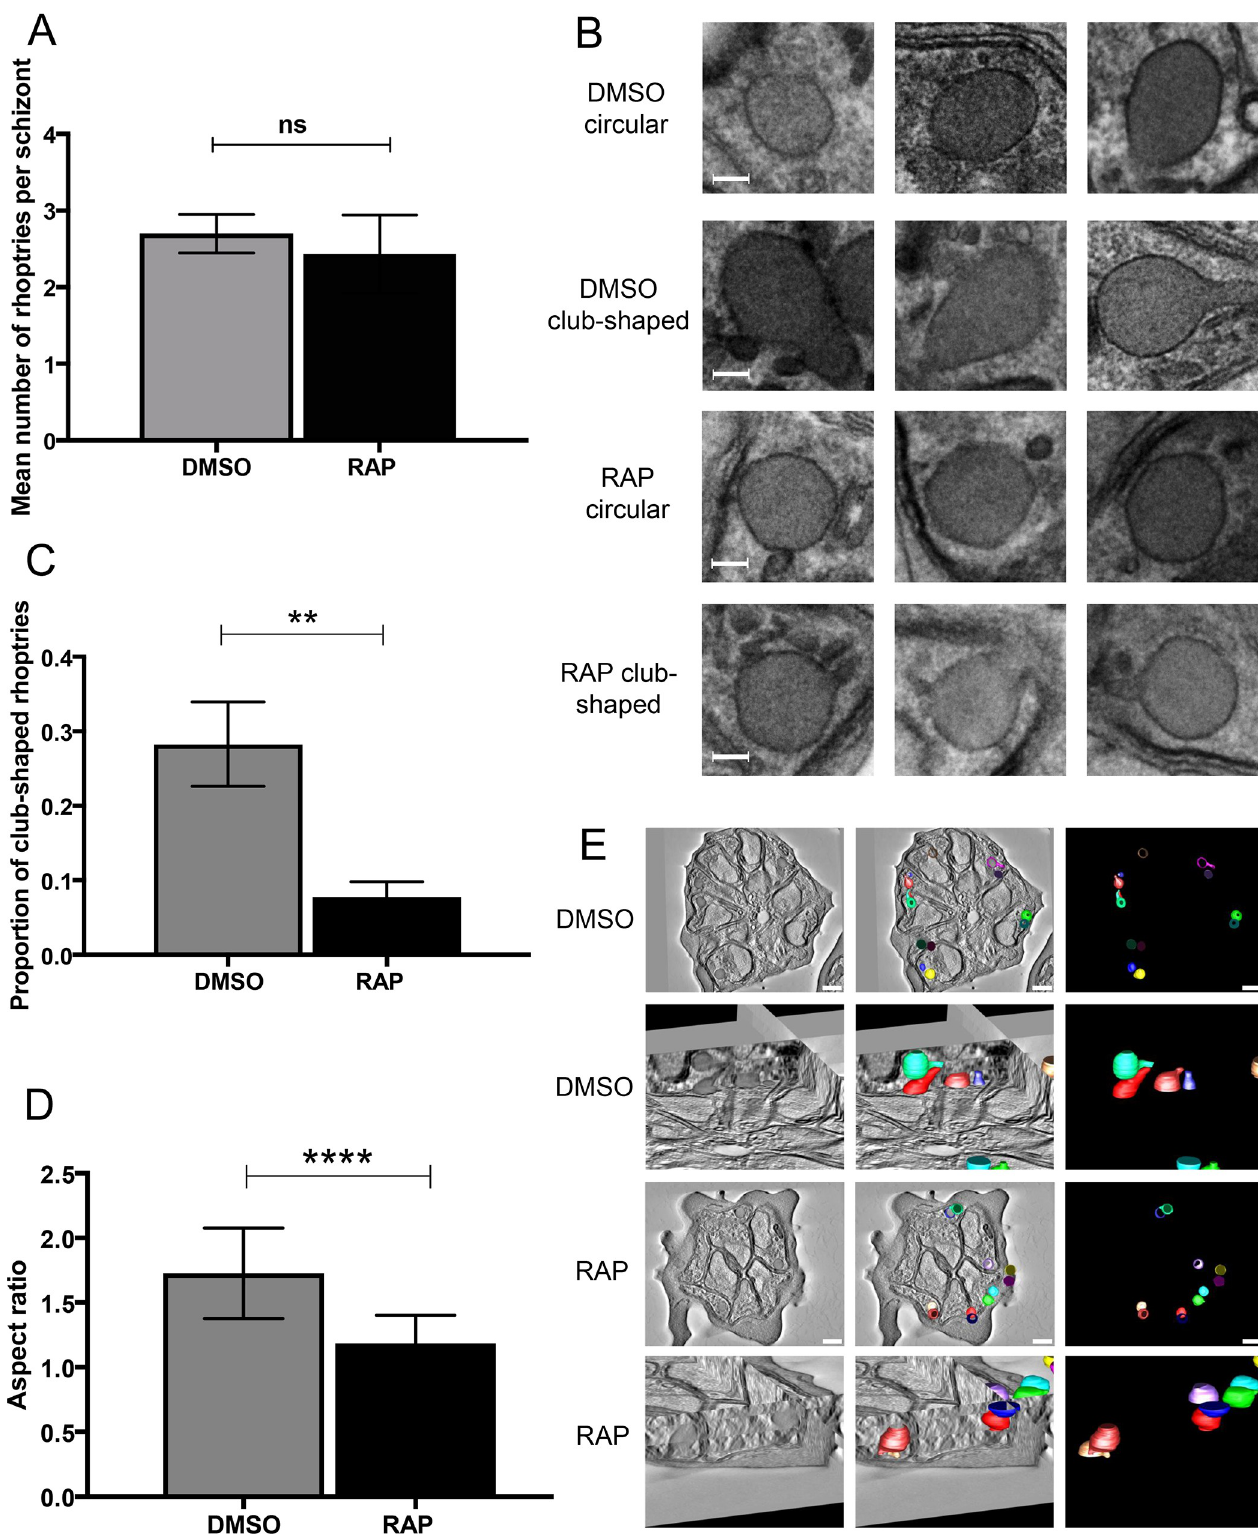
Fig 5. Disruption of RAMA leads to defective rhoptry morphology and reduced rhoptry neck formation. Tightly synchronised mature schizonts from DMSO- or RAP-treated cultures of RAMAloxP clone 9C10 parasites were fixed and processed for TEM, then three sections from each sample taken and 20